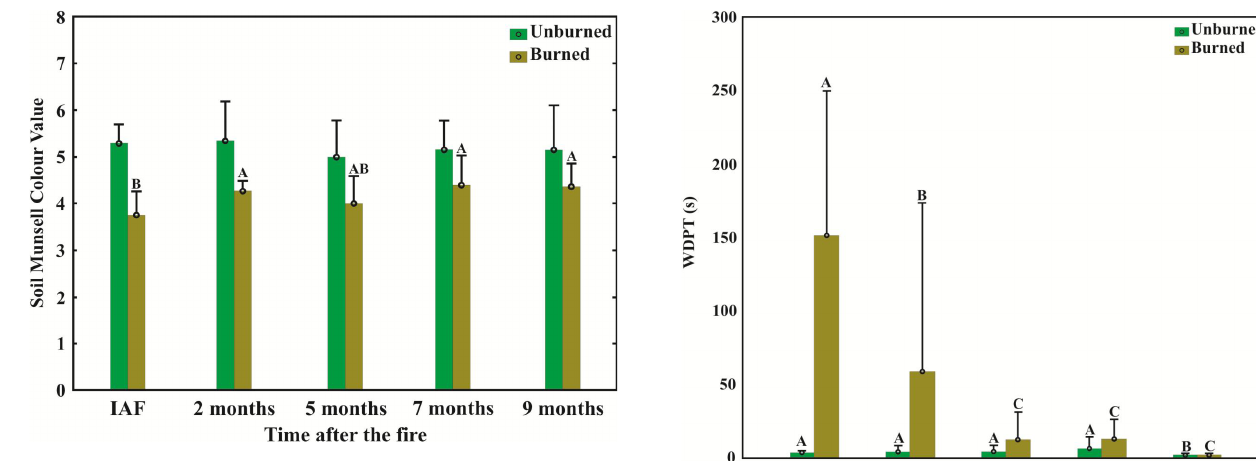
Fig. 1. Evolution of soil Munsell value in the unburned and burned plots in the post-fire sampling dates (bars represent ± standard de- viation). Different letters indicate significant differences ( p < 0.05) among times. IAF (Immediately After the Fire).